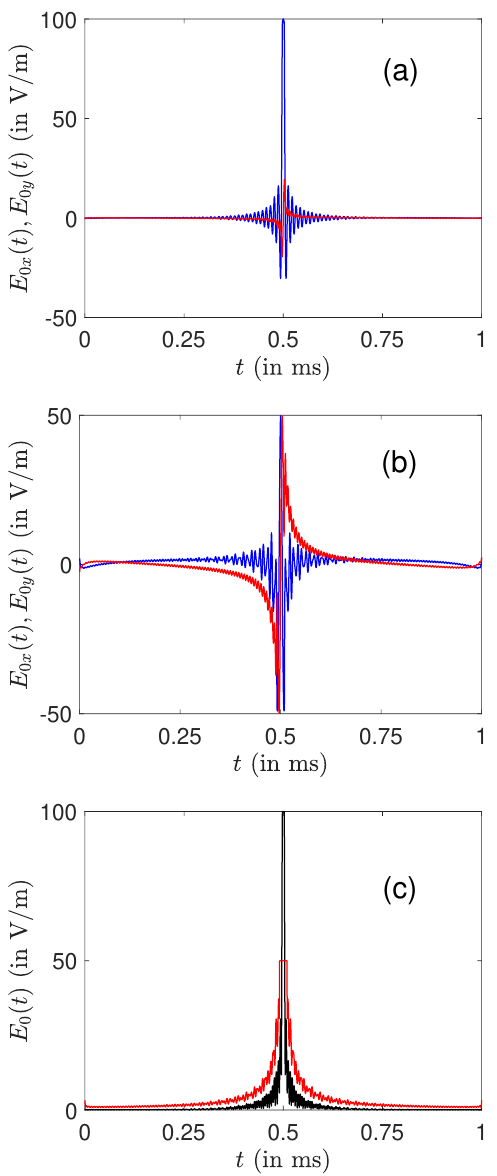
Figure 4. Plot of the optimal amplitudes E 0 x (blue or dark gray) and E 0 y (red or light gray) for a maximum amplitude of 100 V·m − 1 ( a )) and 50 V·m − 1 ( b ). ( c ) The corresponding total amplitude (cid:113) + E 2 E 0 = E 2 0 x 0 y